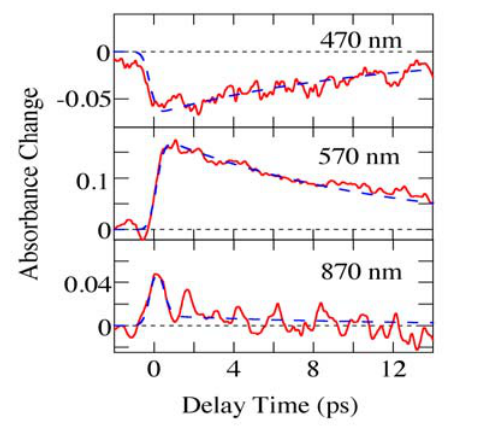
+ to 2 1 A - state u g